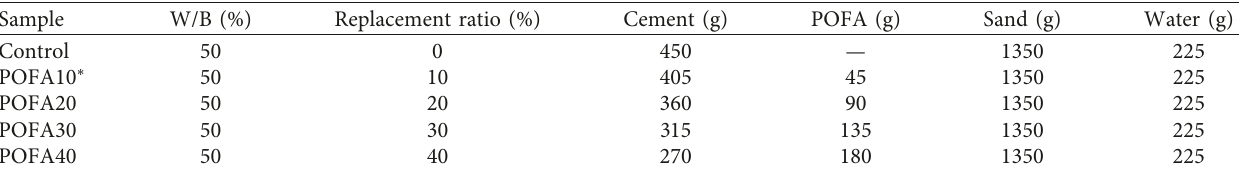
Table 3: Mix proportion of control mortar and mortar specimens containing mPOFA.